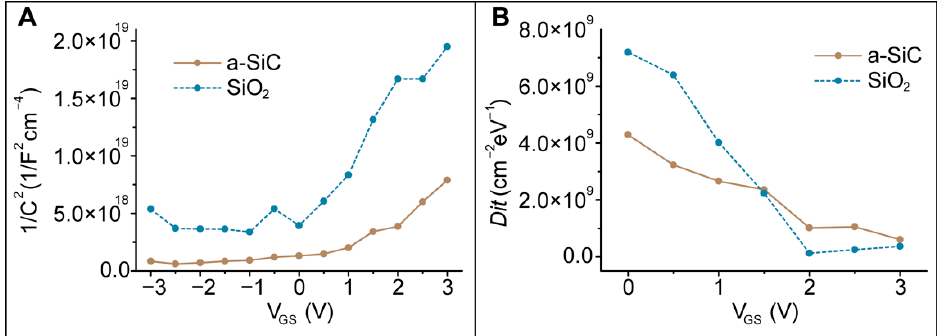
Figure 11. ( A ) Mott–Schottky plot for a-SiC and SiO2. Flat band potential evaluation for a-SiC and